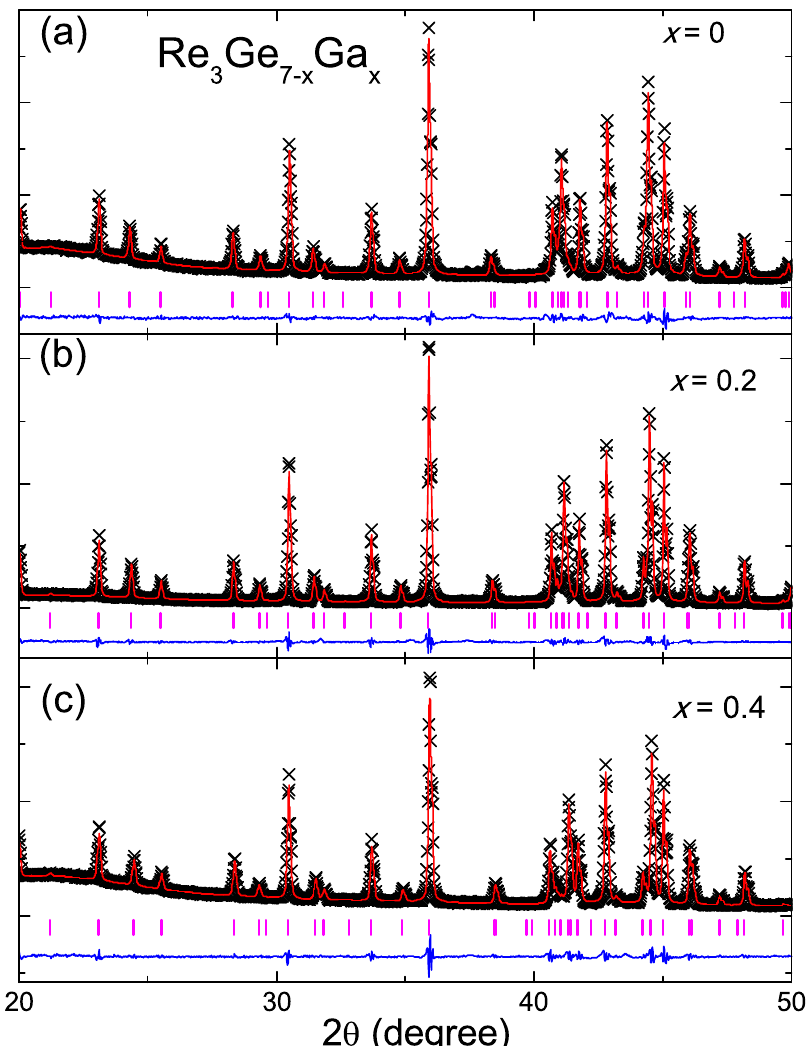
Fig. 2 Structural re fi nement of Re 3 Ge 7 − x Ga x . a – c Structural re fi nement pro fi les in the 2 θ range of 20 to 50 ∘ for the Re 3 Ge 7 − x Ga x samples with x = 0, 0.2, and 0.4,